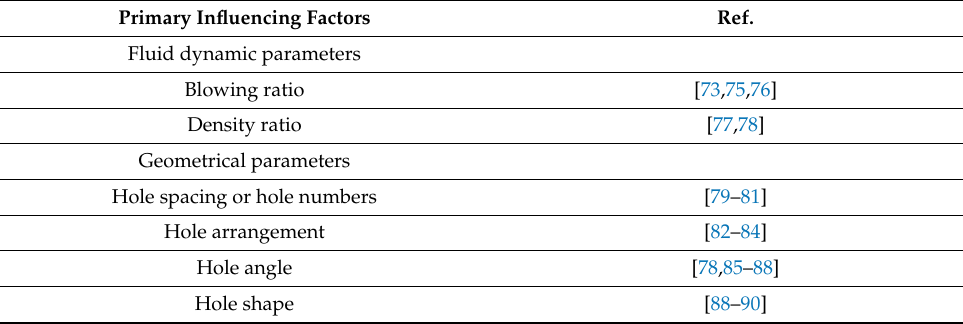
Table 1. Primary factors affecting effusion cooling performance.